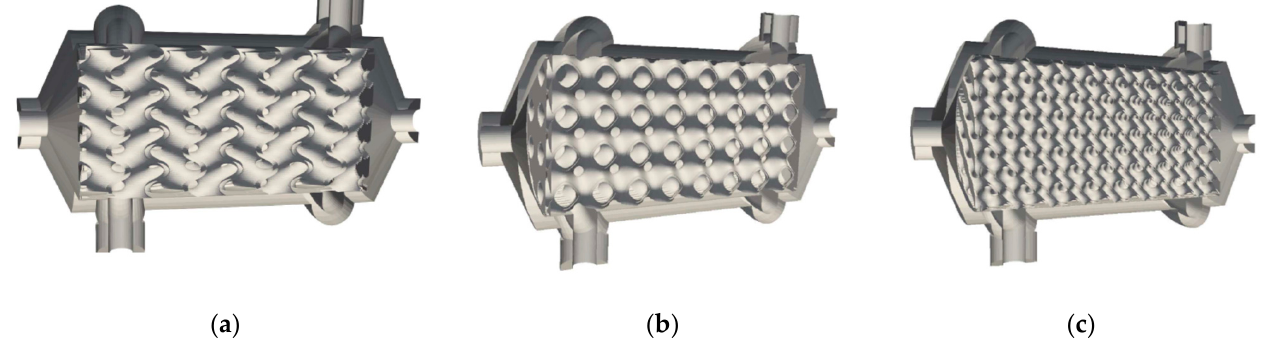
Figure 9. A cross-section through a heat exchanger in the research of [127].